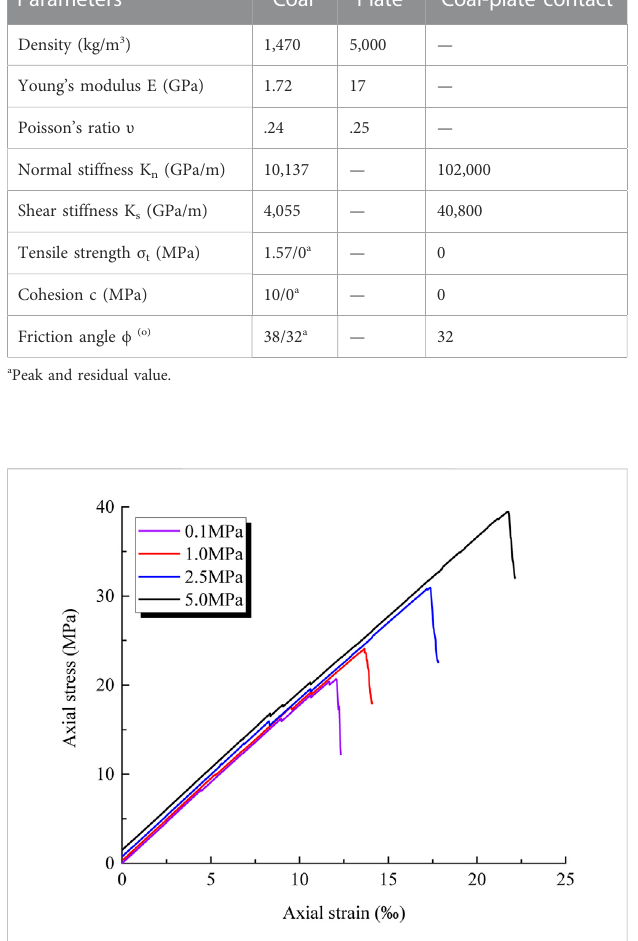
FIGURE 3 Stress-strain curves of numerical samples under different pre- con fi ning